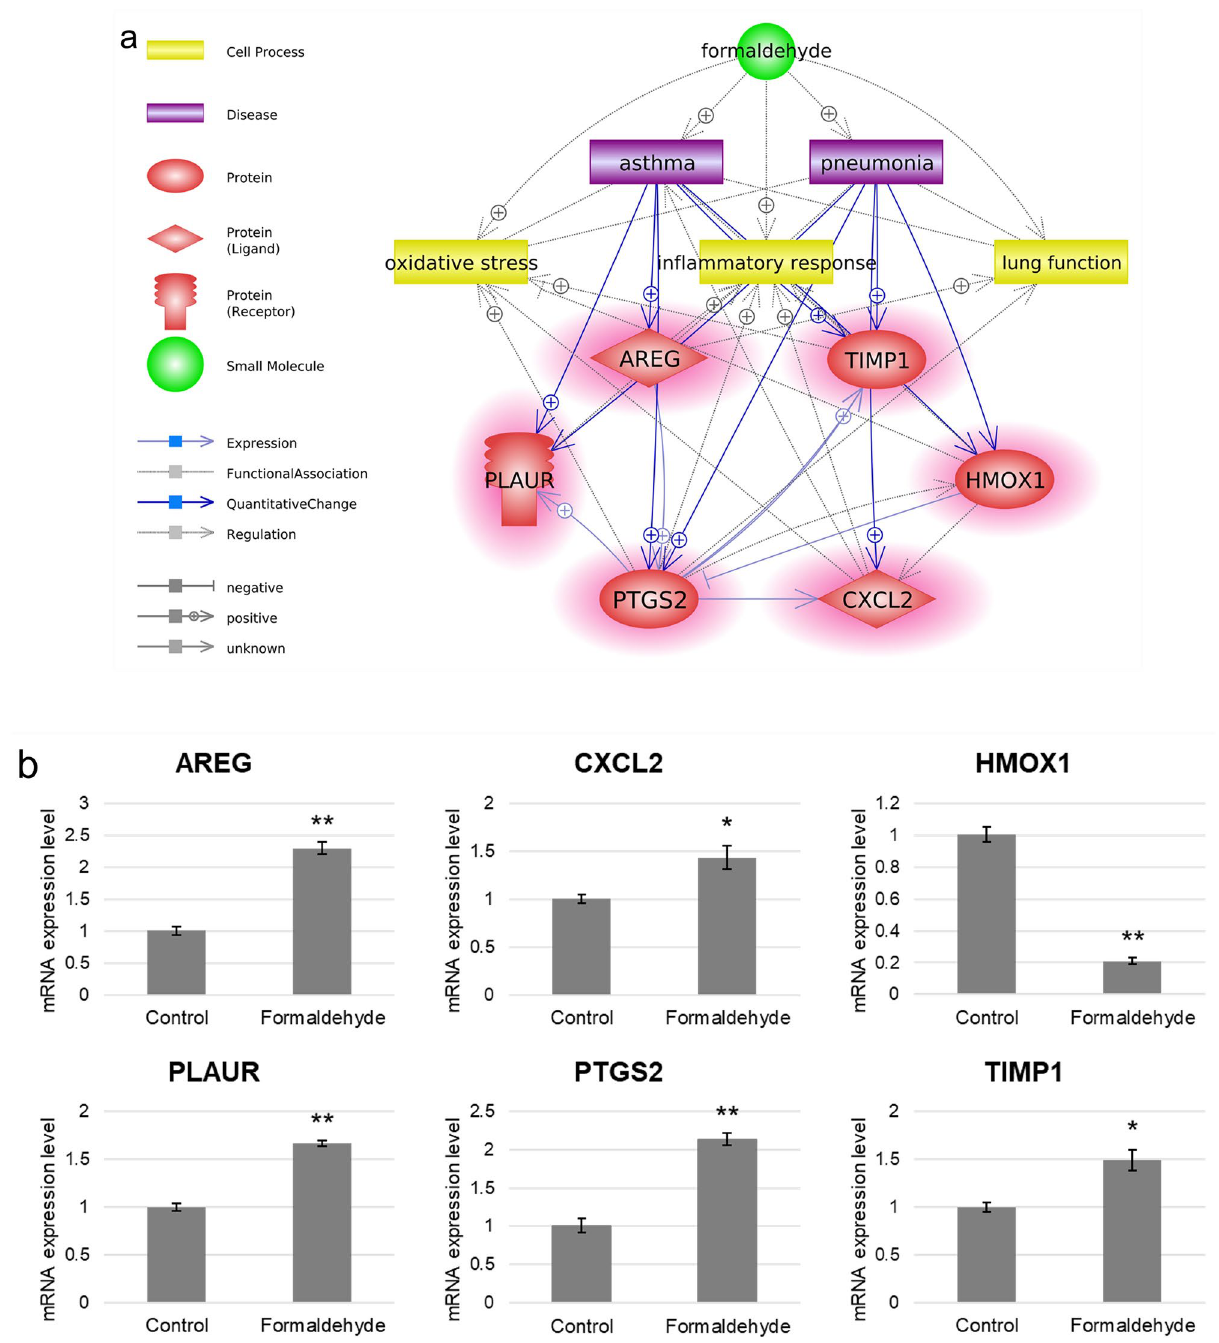
Figure 5. Validation of hub genes in SoluAirway. ( a ) Summarized core interactions of hub genes using Pathway Studio (version 12.3). Red highlights indicate upregulated DEGs. ( b ) Validation of the expression levels of hub genes using qRT-PCR. Error bars represent ± SEM. Single asterisk (*) and double asterisks (**) indicate p -value < 0.05 and < 0.01,